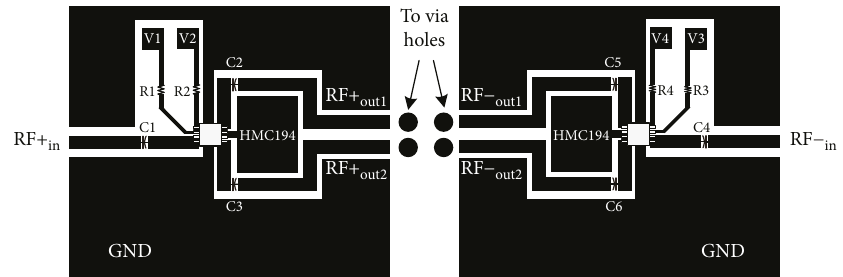
Figure 6: Layout of the SPDT switching circuit board using CMOS diodes for alternative feedings.